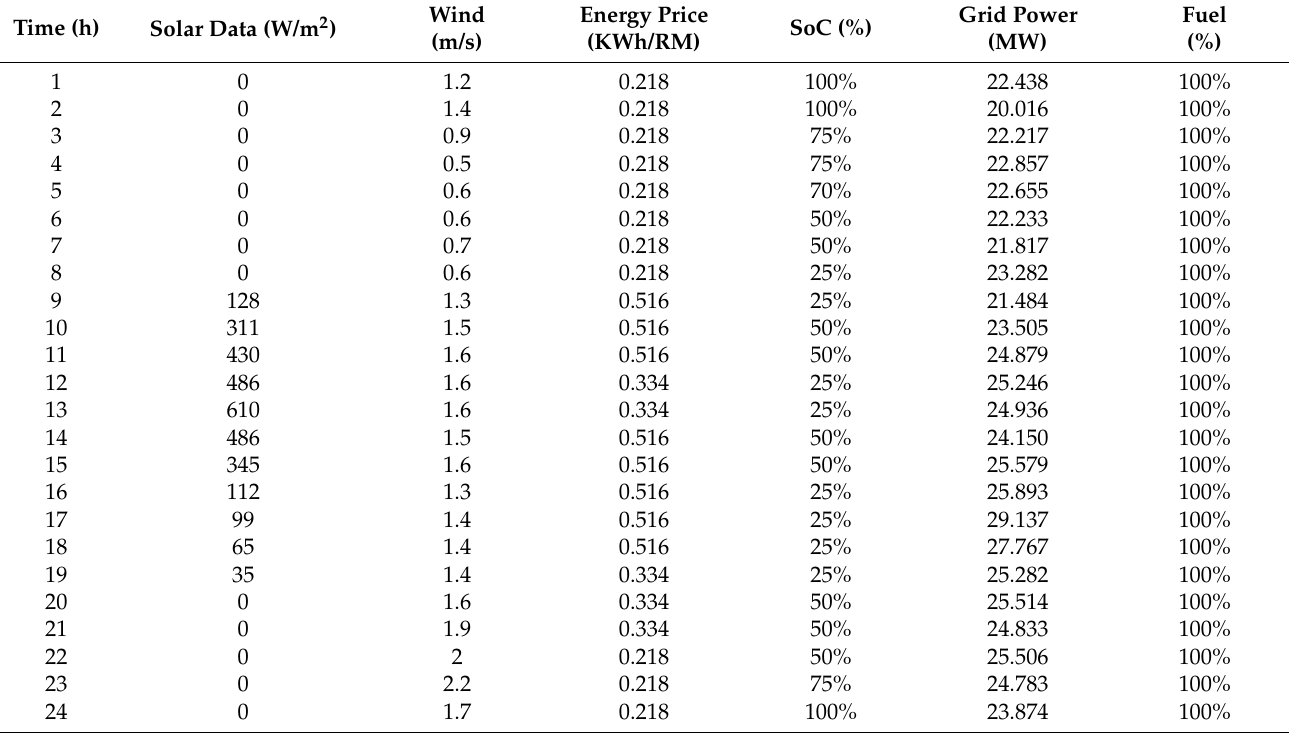
Figure 4. Block diagram of neural network net schedule controller.